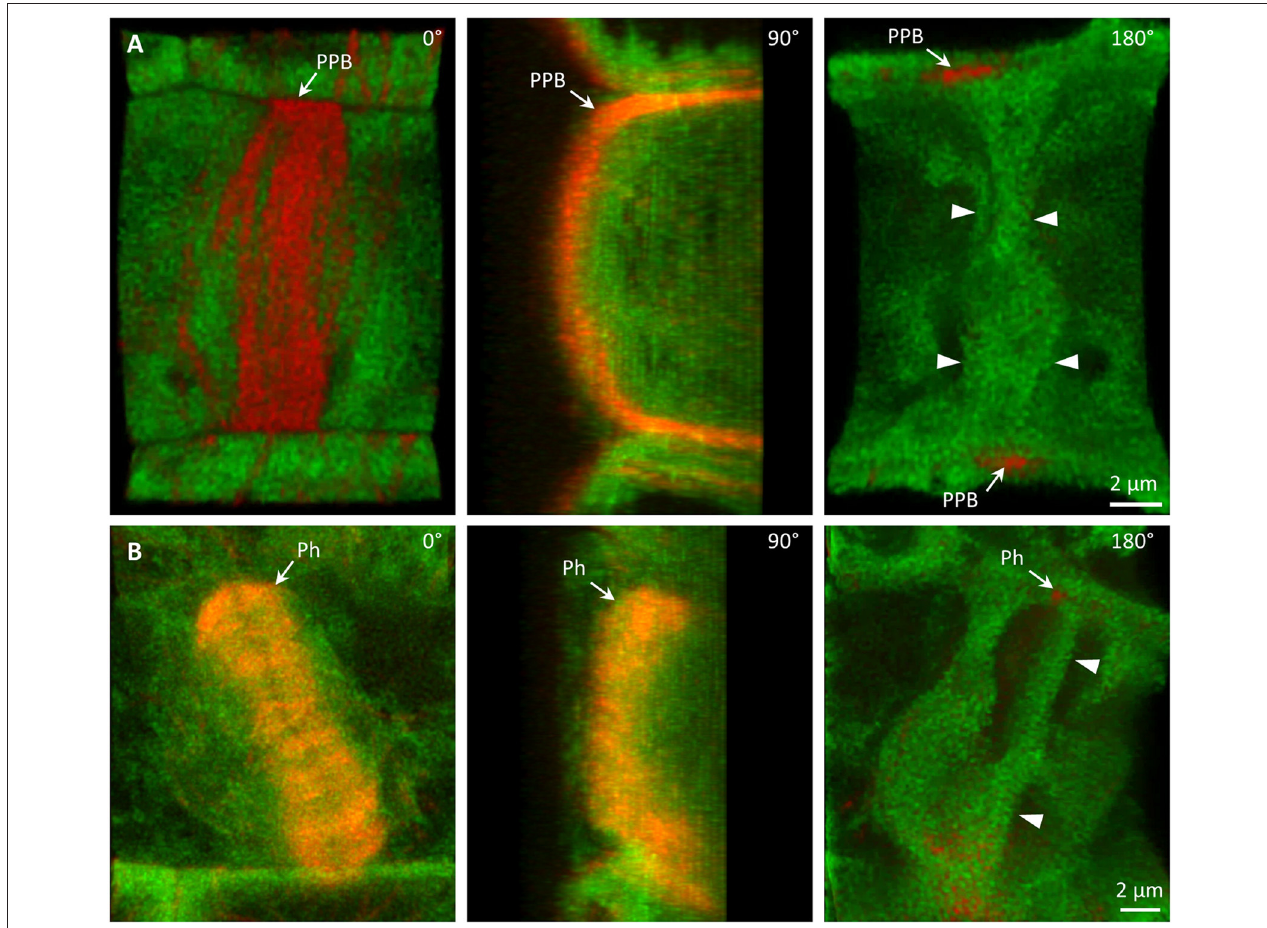
FIGURE 9 | Association of PLD α 1-YFP with microtubules during cell division. Live cell imaging of dividing leaf epidermal petiole cells of complemented pld α 1-2 mutant seedlings expressing PLD α 1-YFP and mRFP-TUB6. (A) Rotation of 3-D reconstructed pre-prophase cell with established PPB (arrows) showing localization of PLD α 1-YFP in cytoplasmic disk between cell nucleus and cortical PPB zone (arrowheads). Individual positions of rotating orthogonal projection correspond to Video S1 . (B) Rotation of 3-D reconstructed cytokinetic cell with ring phragmoplast (Ph, arrows) showing localization of PLD α 1-YFP among